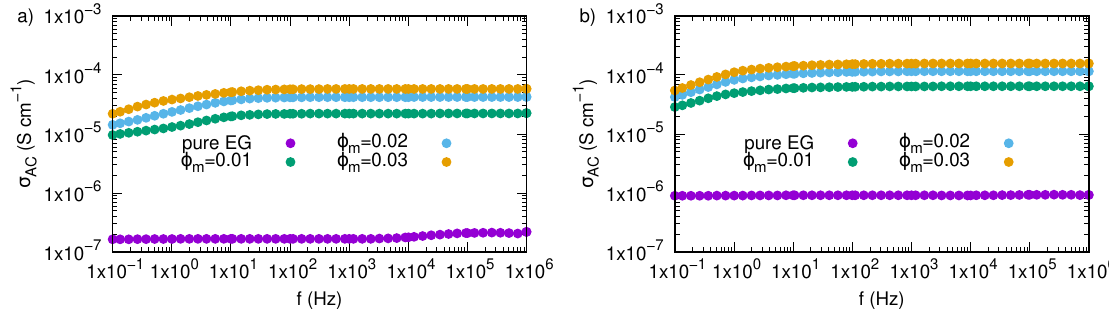
Figure 14. Electrical conductivity of permittivity of silicon oxide lignin ethylene glycol nanofluids as function of frequency for temperature ( a ) 298.15 K, ( b ) 333.15